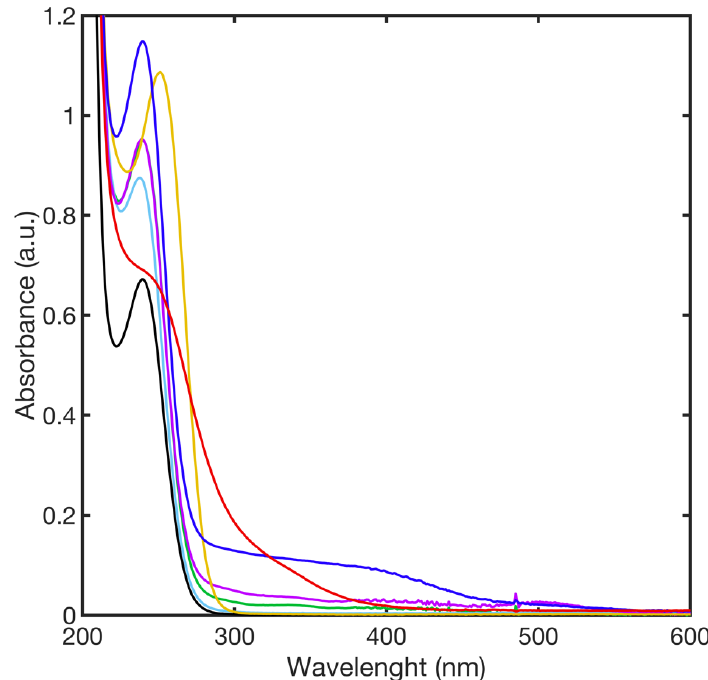
Figure 3. UV-Vis spectra of complexes formed upon the addition of metal ions to the 11MUA in NaOH solution; 11MUA (black line), Ni 2+ (green line), Mn 2+ (blue line), Cu 2+ (red line), Zn 2+ (cyan line), Co 2+ (purple line), and Cd 2+ (yellow line).